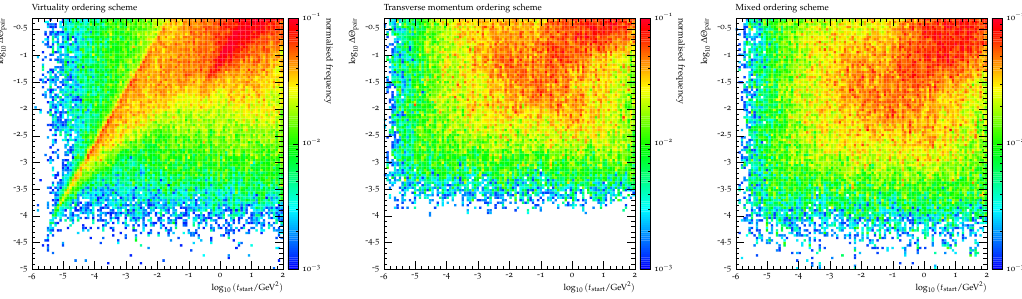
Figure 2 . The interdependence of the starting scale t start of a photon and the angular separation between the particles produced in its splitting, ∆Θ pair , in the in the ¯ q -ordered scheme (left), the k T -ordered scheme (centre), and the mixed ordering scheme